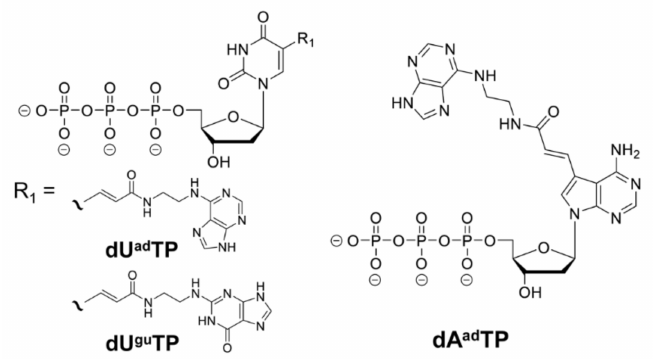
Figure 1. Chemical structures of dU ad TP, dU gu TP, and dA ad